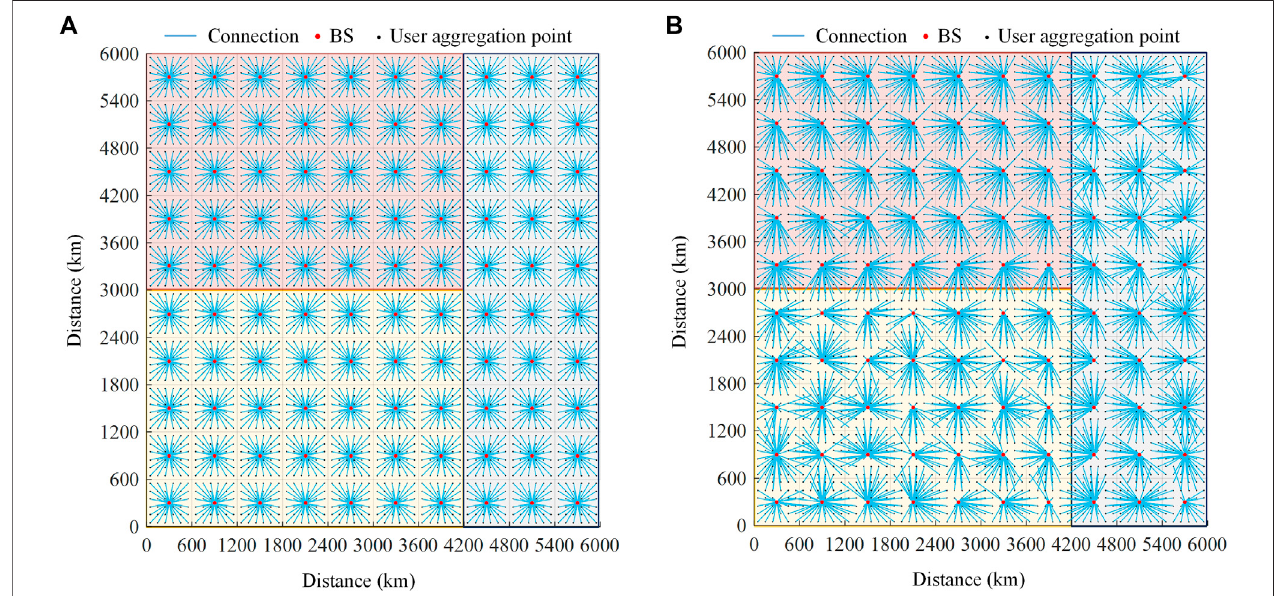
FIGURE 1| Connection diagram ofBS and user aggregation point before and after optimization. (A) Connection diagram ofBS and user aggregation point before optimization. (B) Optimized connection diagram of BS and user aggregation point.